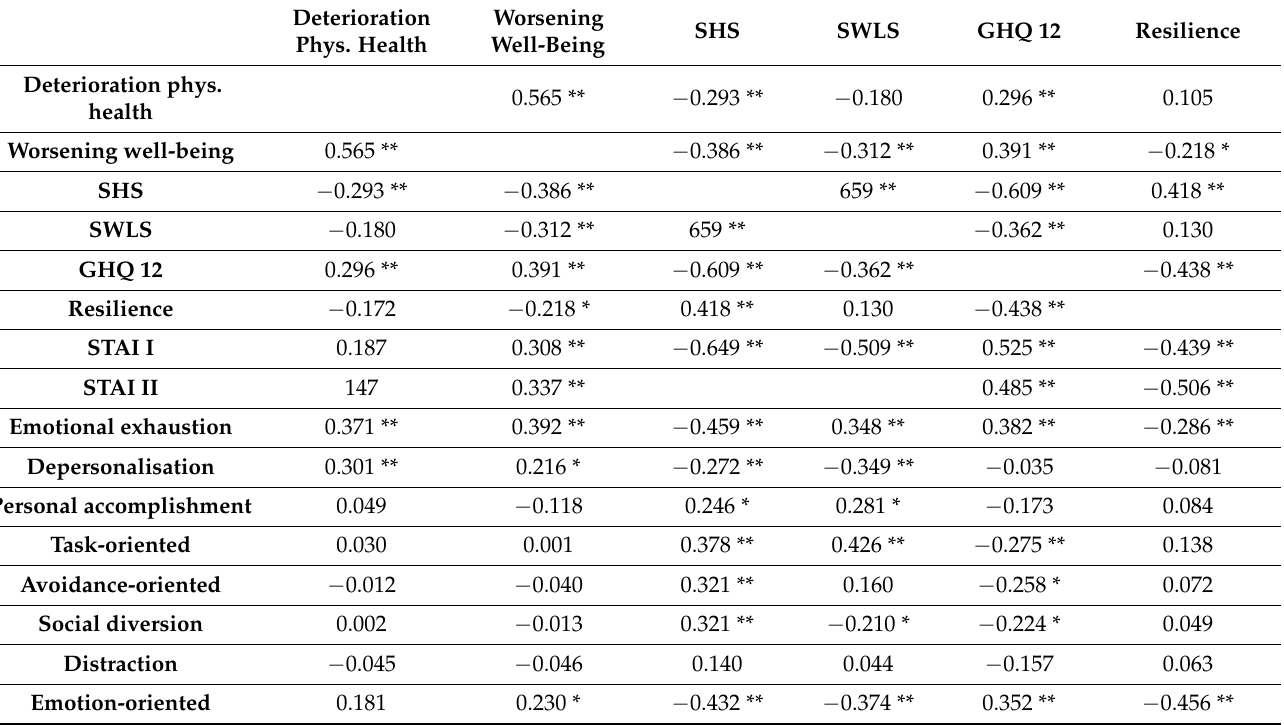
Table 4. Correlation between some indicators of health, well-being, burnout and coping strategies. Deterioration Worsening SHS SWLS GHQ 12 Resilience Phys. Health Well-Being Deterioration phys.